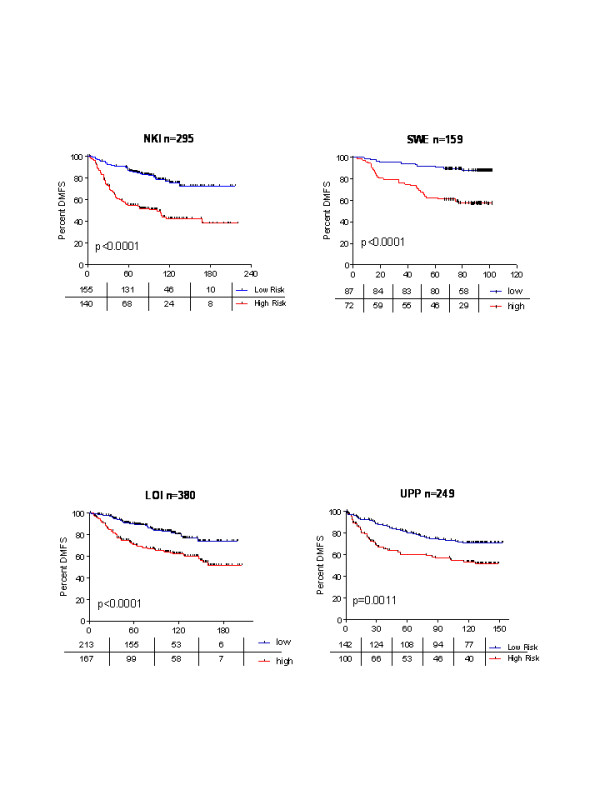
Kaplan-Meier curves showing distant metastasis-free survival (DMFS) for patients included in four databases available online.